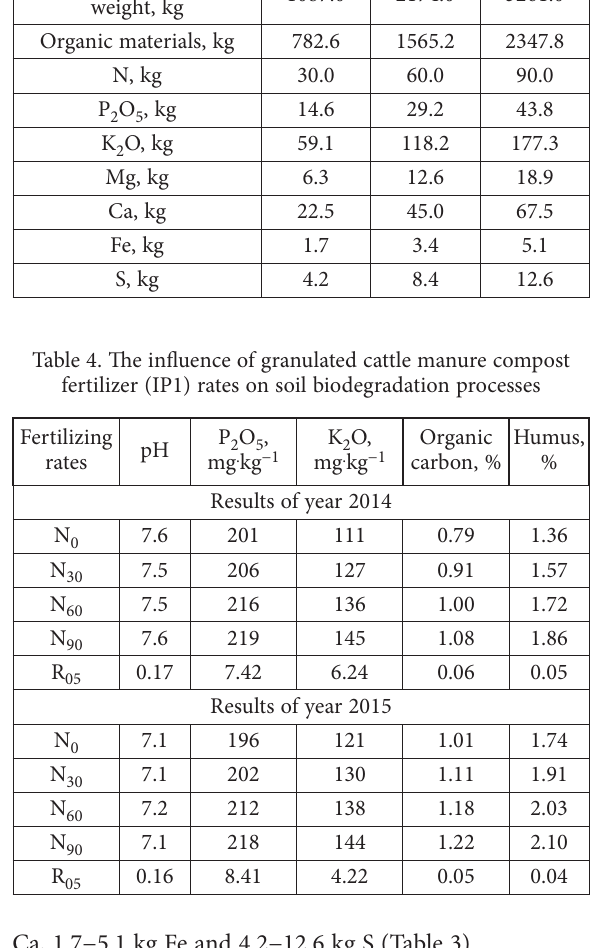
Table 3. The amount of nutrients entering in the soil by fertilizing with different cattle manure compost granulated fertilizers Indicator N 30 N 60 N 90 Fertilize by physical 1087.0 weight, kg Organic materials, kg